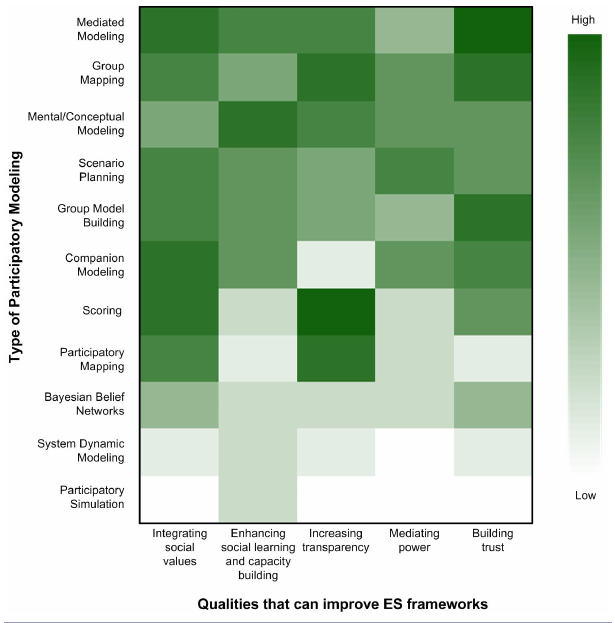
Fig. 1 . Participatory modeling (PM) types were scored on a scale of 0 - 1 (0 = Low, 1 = High), ranked by the average (assuming no weighting), and organized from highest total score (top) to lowest total score (bottom). PM types at the top of the figure are likely to contribute more to the development of ecosystem services (ES) frameworks that can address wicked problems than those located toward the